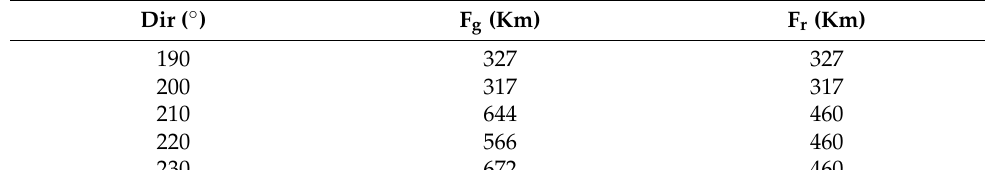
Table 4. Geographical (F g ) and reduced (F r ) fetch.